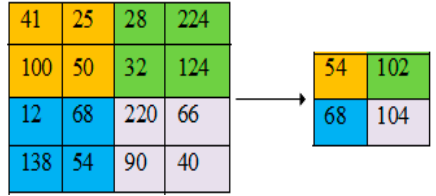
Figure 2. 2 × 2 average pooling with stride 2.